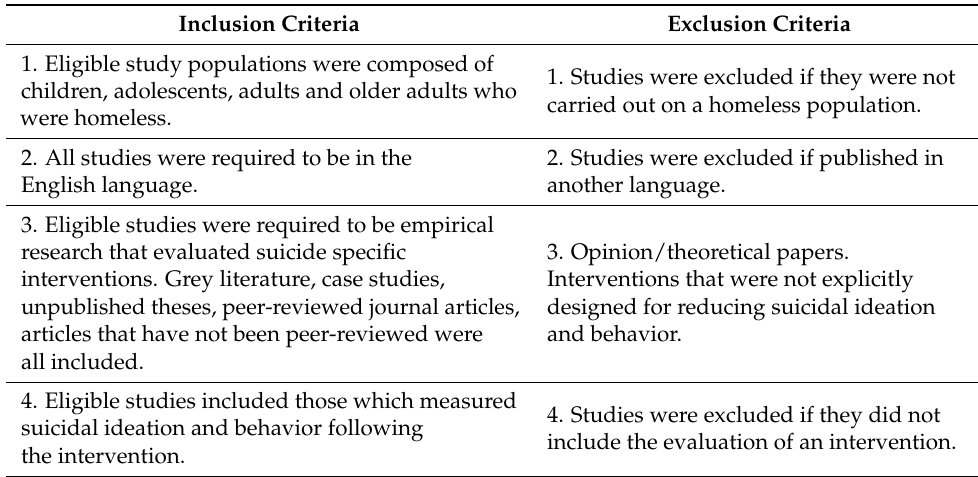
Table 2. Eligibility criteria for selection of